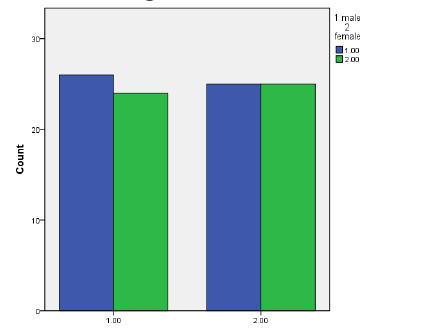
Figure (1) Bupivacaine with normal saline versus bupivacaine with nefopam in term of age in years, there is no significant statistical difference (p=0.154)